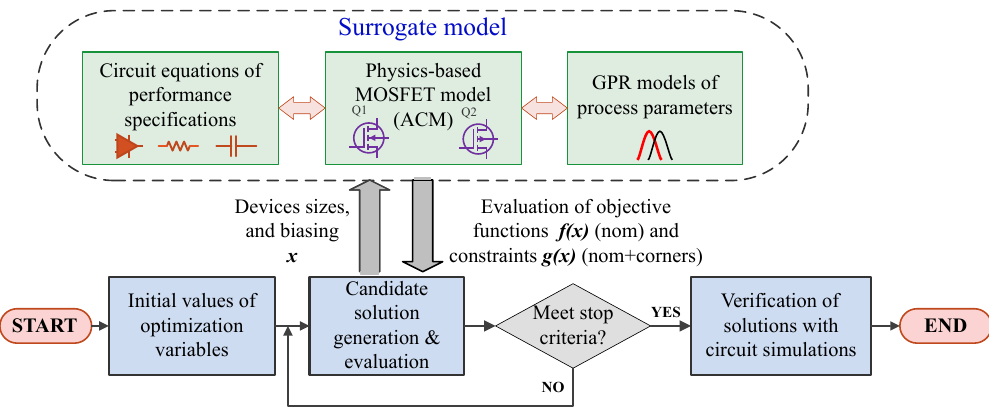
Figure 1. Proposed surrogate model inserted on a modular optimization framework for automatic IC